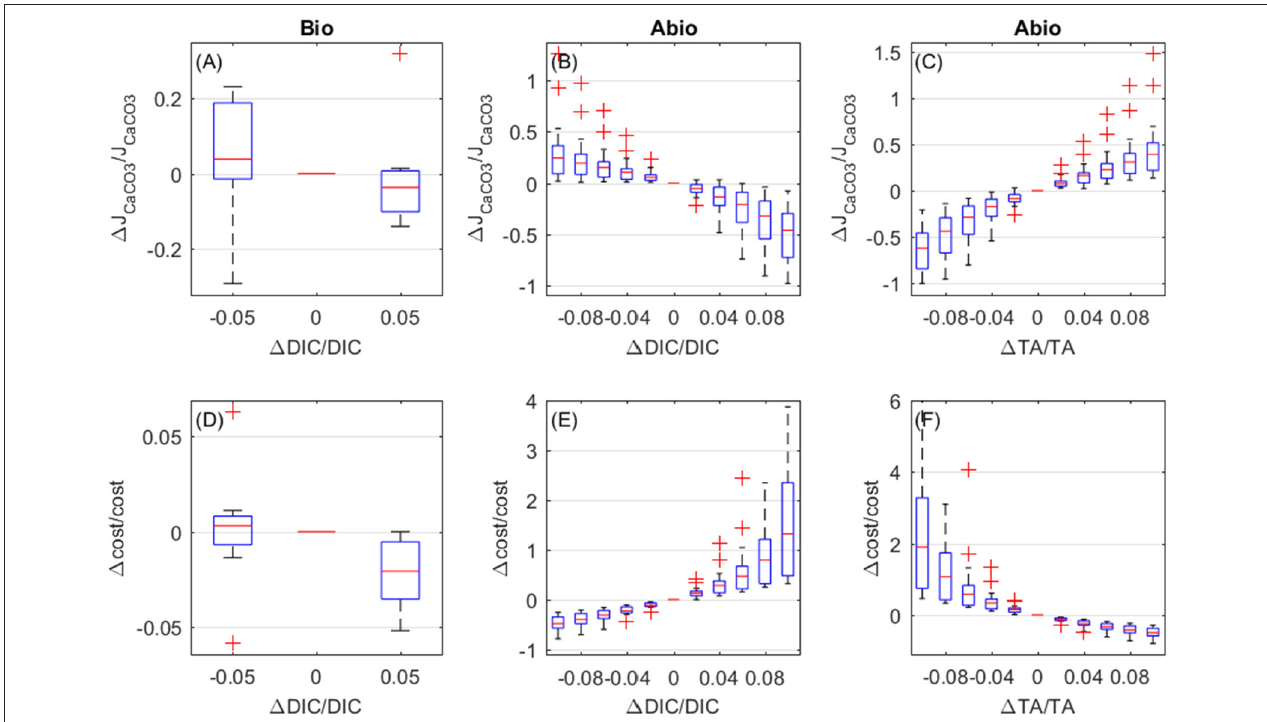
FIGURE 9 | Biologically-mediated (A,D) and abiotic (B,E) effects of DIC and abiotic effects of TA (C,F) , fractional change in calcification rates (top panels) and calcification costs (bottom panels). x and y-axis values are indicative of fractional change. Each boxplot represents all